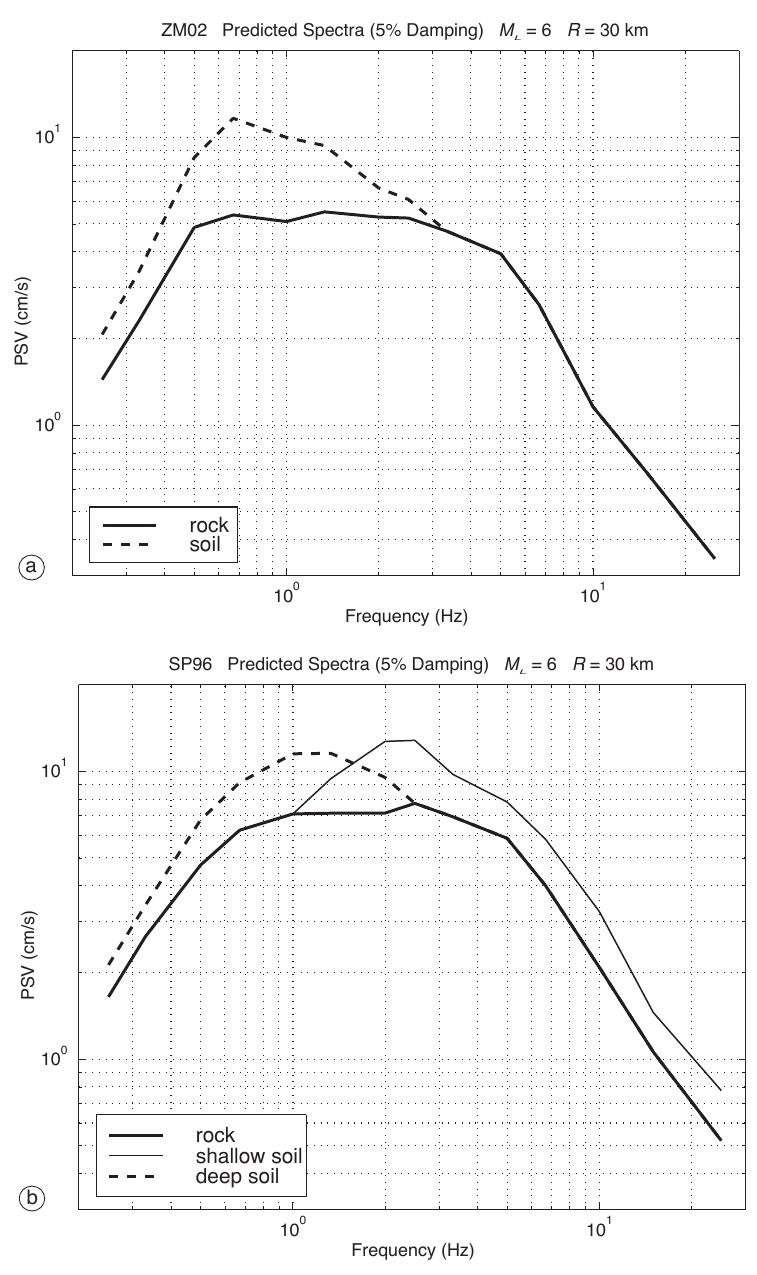
Fig. 6a,b. Predicted velocity response spectra for different soil classes. Figure 6a represents the results of this study for rock (thick solid line) and soil (dashed line); fig. 6b shows the results of SP96 for rock (thick solid line), shallow soil (thin solid line) and deep soil (dashed